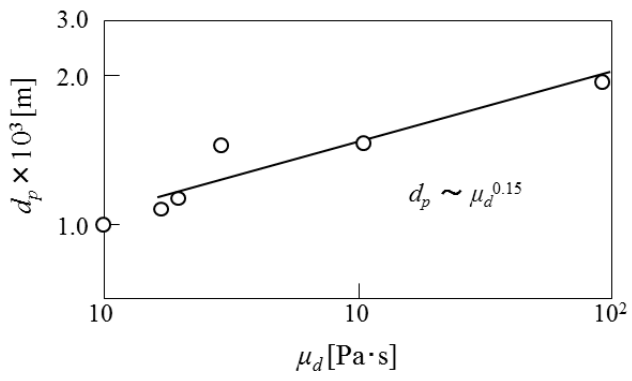
Figure 10. Dependence of mean diameters on viscosity of dispersed phase.